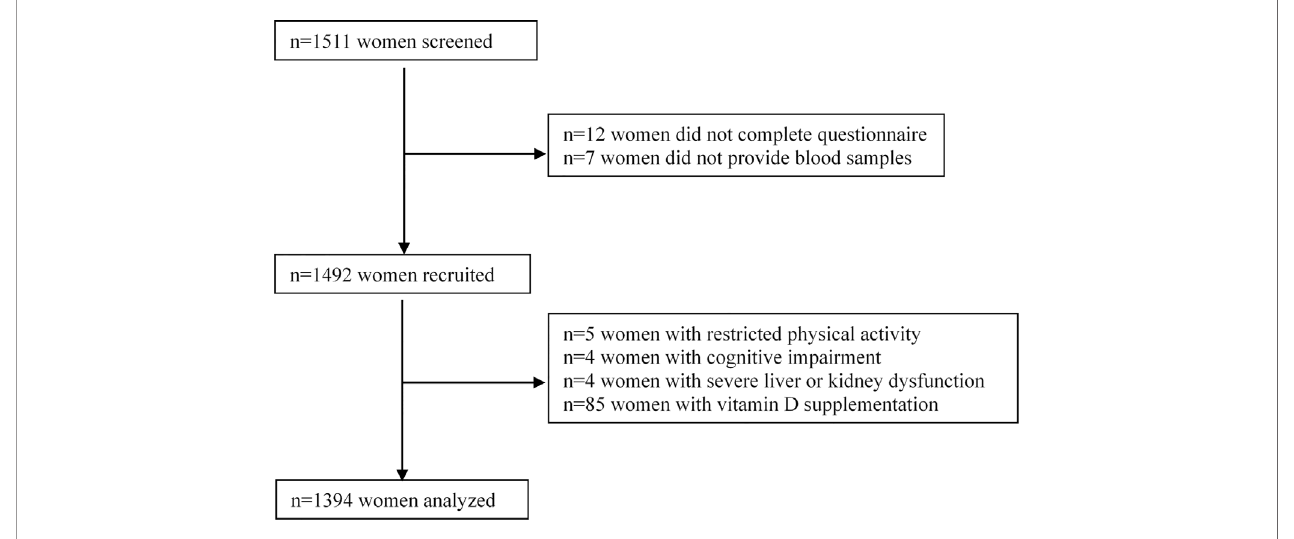
FIGURE 1 | Flow chart for participants